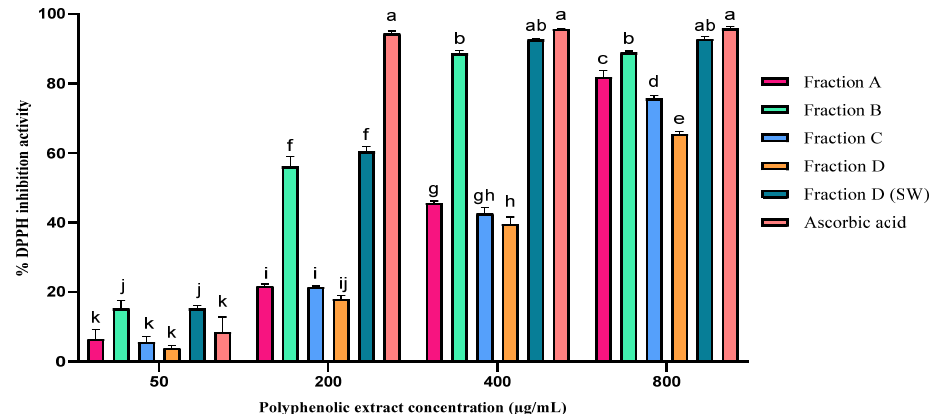
Figure 3. % DPPH radical inhibition activity (% D IA ) of ethanolic extracts (Fractions A, B, C, D) and subcritical water extract (Fraction D (SW)) of apple pomace compared to ascorbic acid. Fraction A (pulp, peel, seed, core, and stem), fraction B (peel), fraction C (seed and core), and fraction D (pulp and peel), data are mean values ± SD from three replicates ( n = 3); mean values with different letters show significant difference at p < 0.05.